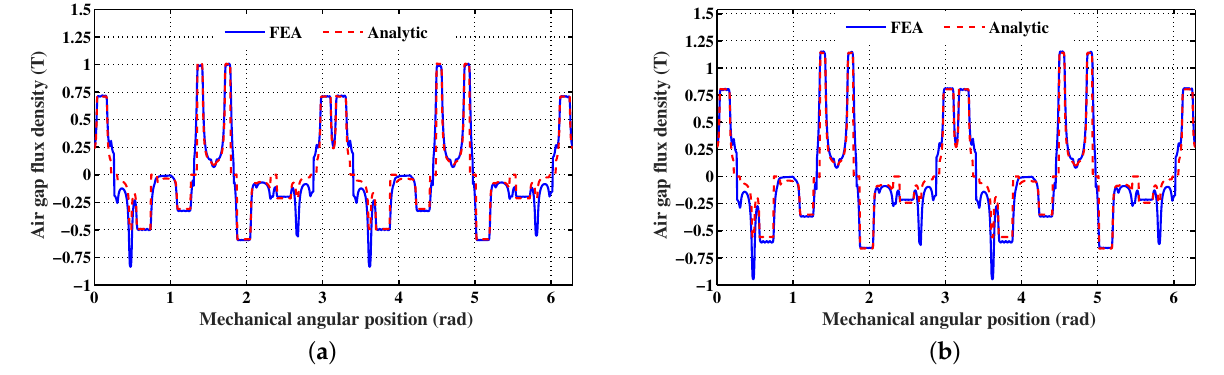
Figure 10. Analytically- and FEA-predicted spatial repartitions of the armature magnetic reaction for θ r = 0 ◦ . Legend: ( a ) I max = 3.6 A, ( b ) I max = 4.8 A.